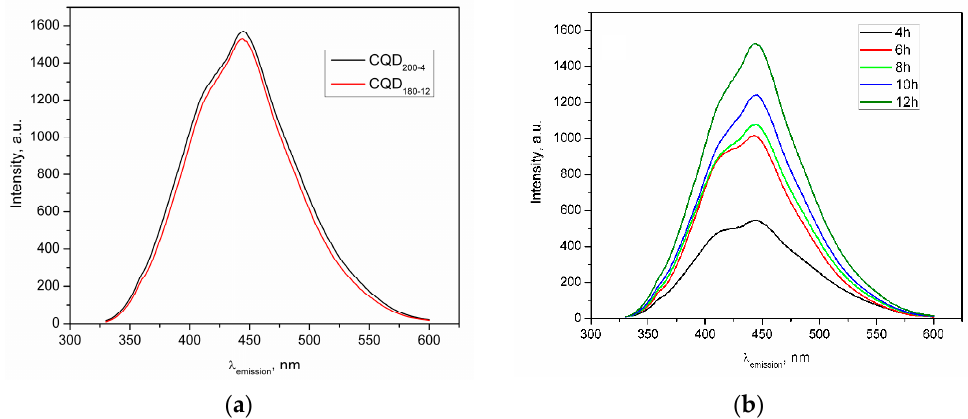
Figure 1. ( a ) Emission spectra ( λ ex = 310 nm) of the synthesized CQDs at 200 ◦ C and 4 h and at 180 ◦ C and 12 h; ( b ) emission spectra ( λ ex = 310 nm) of the synthesized CQDs at 180 ◦ C as a function of the reaction time.